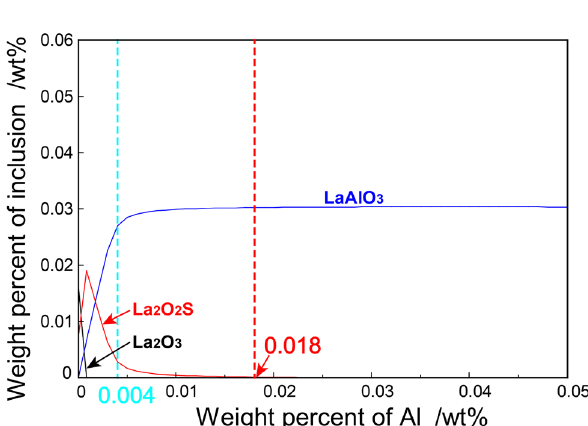
Figure 11: The in fl uence of Al content on the composition of inclusions in steel at